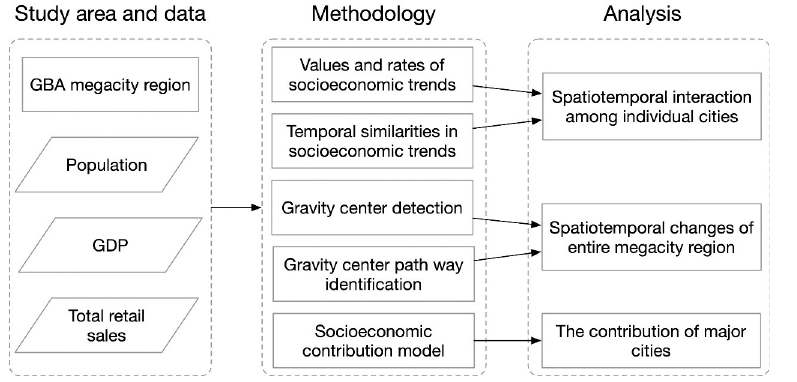
Fig 3. The overview of the research